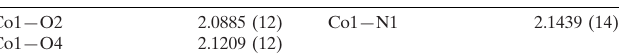
Selected bond lengths (A˚ ).